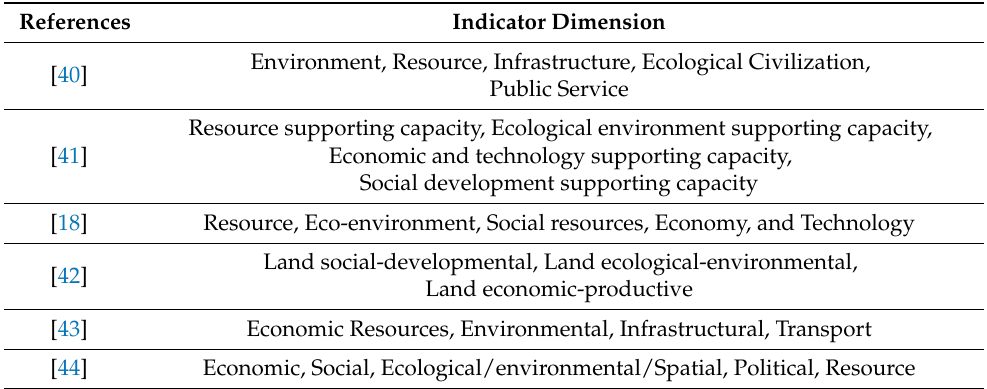
Table 1. Land comprehensive carrying capacity (LCCC) indicator dimensions in existing research studies.